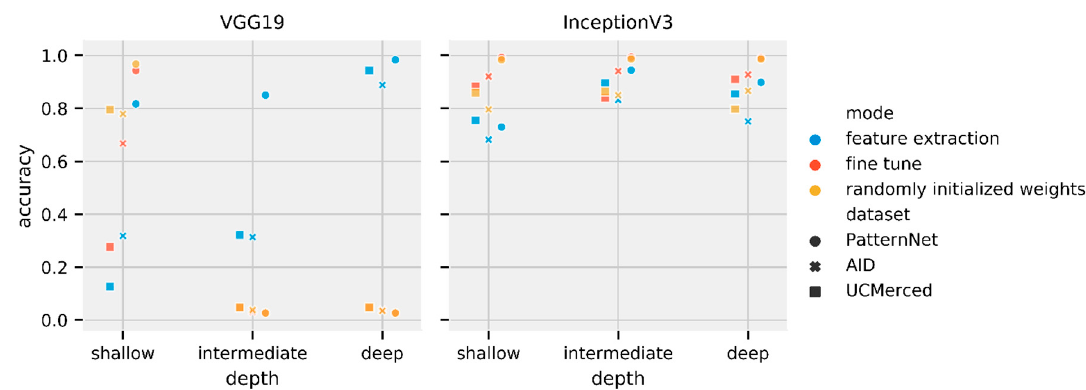
Figure 9. Test set accuracy for all VGG19 and Inception V3 versions trained with all datasets using Adamax (2e-3). Left panel shows VGG 19 results, right panel shows Inception V3 results. Note VGG19 shallow and intermediate feature extraction and fine tuning versions were trapped in local minima.